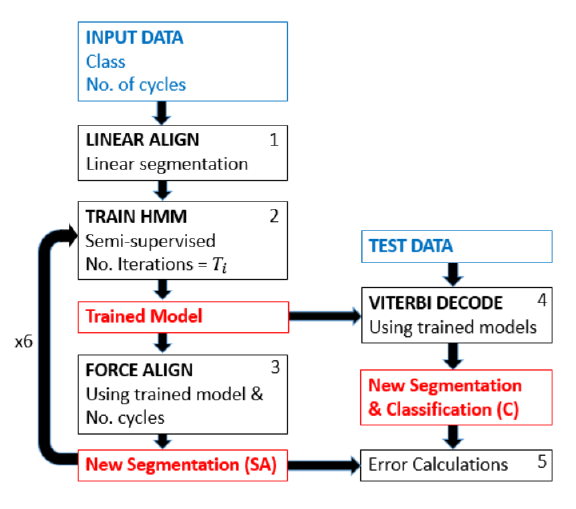
Figure 2. Pipeline showing the smart annotation method on the left and the use of the resulting models for simultaneous classification and segmentation of test data on the